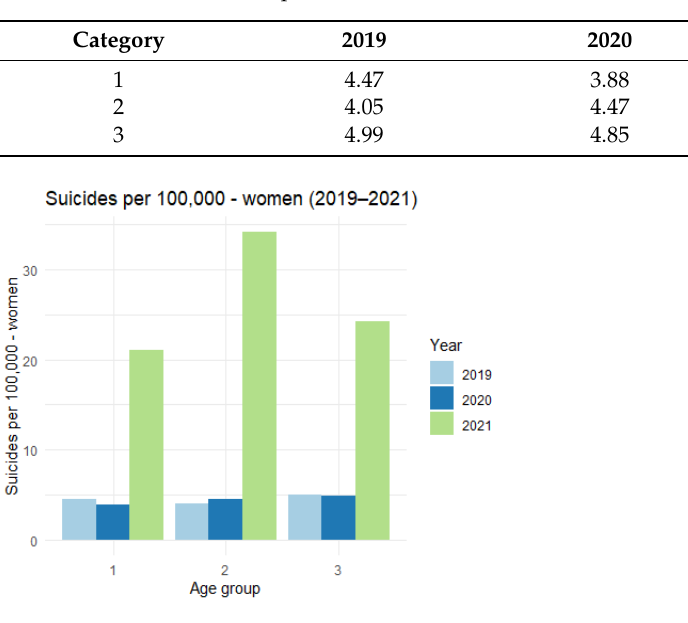
Figure 8. The number of suicides per 100,000—women (2019–2021). Table 5. Number of suicides per 100,000 women (2019–2021).